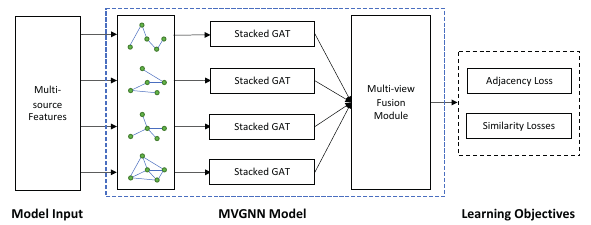
Figure 3. Multi-view graph neural network